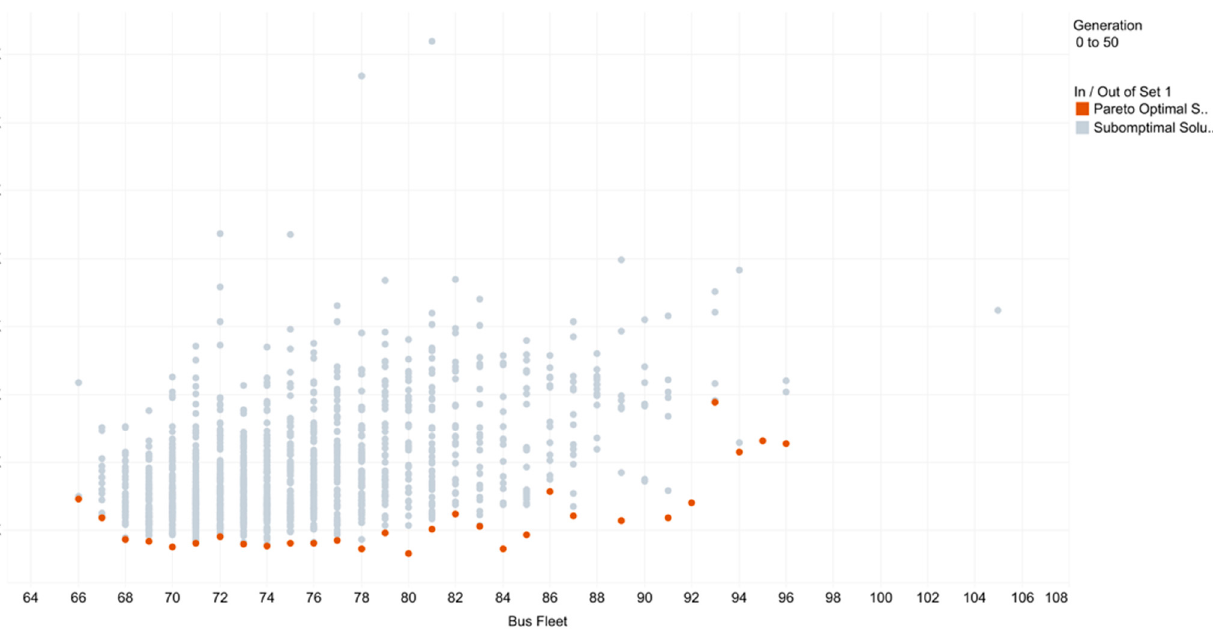
Figure 6. Pareto Optimal solutions for different bus fleets (red dots).